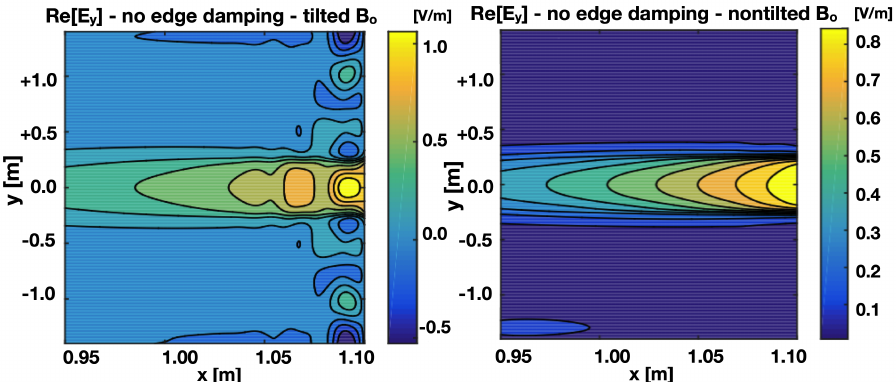
Figure 4. Poloidal component in absence of poloidal edge damping ( left ) and in absence of the antenna tilt ( right ); E y = 1 V/m at the antenna